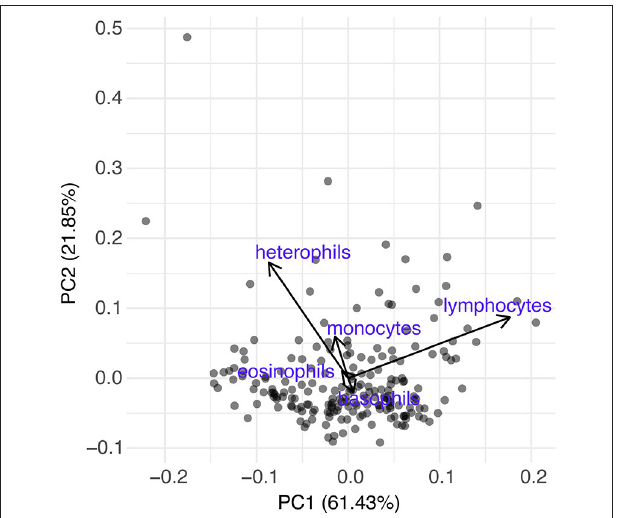
FIGURE 7 | Differential leukocyte counts of both breeds based off a Principle Component Analysis. Based on analysis using PCA1 [PCA1 ∼ treatment + sex + week + (1|Block:Population:Bird ID)], treatment (hedge access) had no significant effect on circulating leukocytes of either breed. The first PC was the only axis used in our analysis and based on loadings was driven mainly by heterophils ( − 0.44) and lymphocytes (0.89). Other loadings include basophils (0.03), eosinophils ( − 0.04), and monocytes ( −